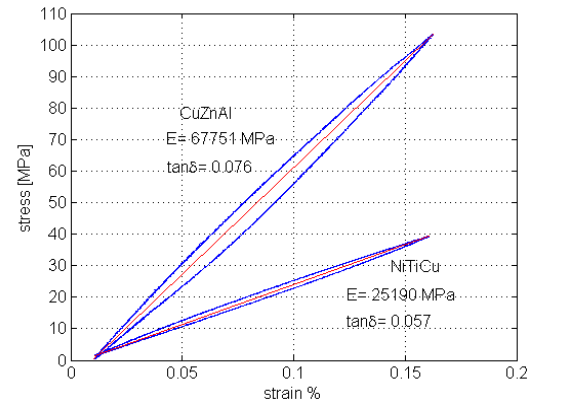
Figure 7: Stress-strain hysteresis loop for CuZnAl and NiTiCu during MTS tensile test at 0.075% strain